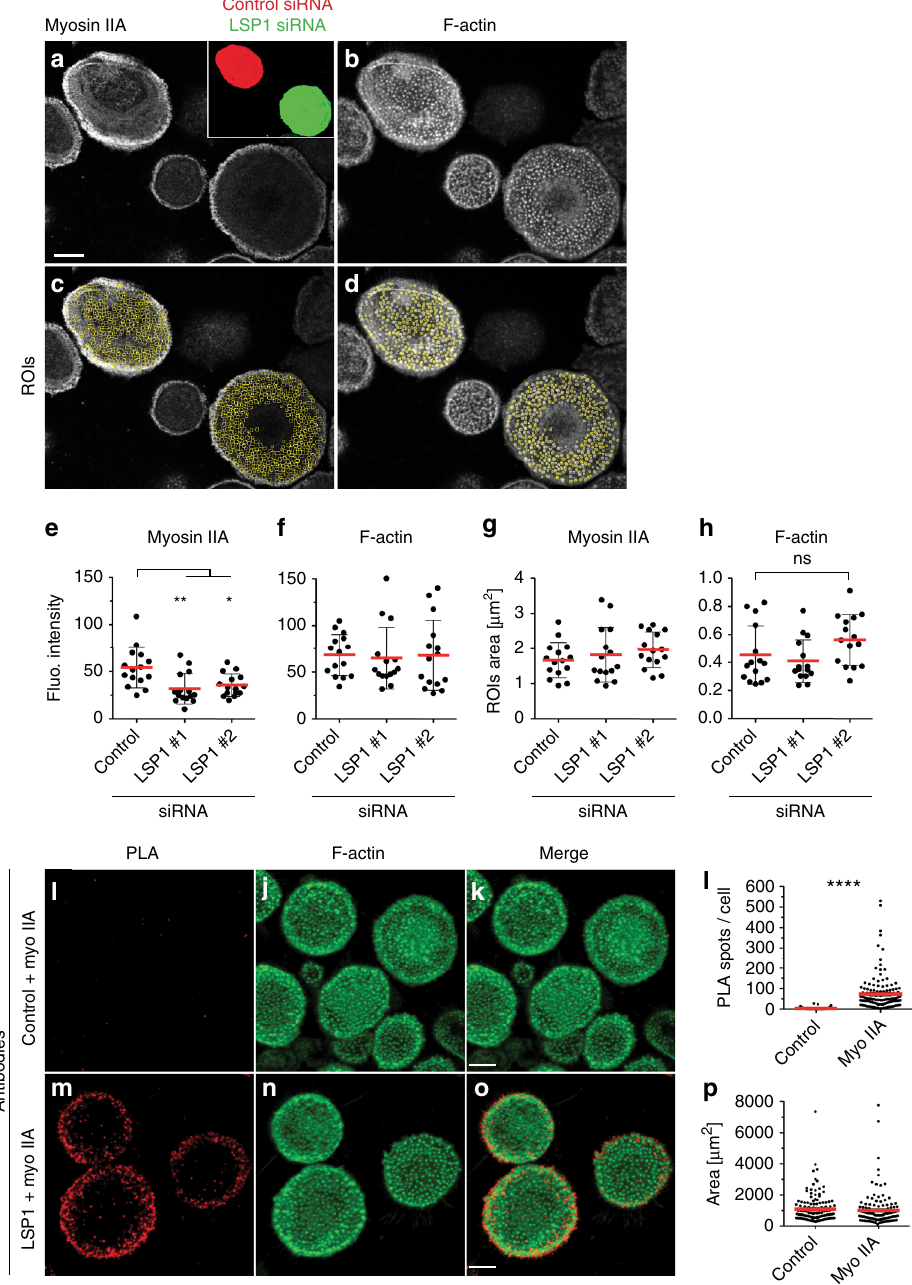
Fig. 4 LSP1 interacts with myosin IIA and regulates its recruitment to podosomes. a , b Confocal micrographs of mixed populations of macrophages, stained for myosin IIA using speci fi c primary antibody ( a ) or for F-actin using Alexa-405-labeled phalloidin ( b ). Cells treated with LSP1 siRNA express GFP, cells treated with control siRNA express mCherry, as shown in inset in a . c , d ImageJ-based macros were used to identify myosin IIA at podosomes ( c ) and F-actin-rich podosome cores ( d ). Scale bar: 10 µ m. e – h Statistical evaluation of ( e ) myosin-based fl uorescence at podosomes, ( f ) F-actin-based fl uorescence at podosomes and size of areas analysed for podosomal myosin IIA ( g ) and F-actin ( h ) podosome-covered area. Each dot represents the mean intensity of all the individual podosomes detected in a single cell (~500 podosomes/cell on average), fi ve cells from three different donors. Values are given as mean ± SD. * P < 0.05, ** P < 0.01, one-way ANOVA test. i – k , m – o Confocal micrographs of macrophages subjected to a proximity ligation assay (PLA), using myosin IIA-speci fi c antibody, together with control IgG ( i ) or LSP1-speci fi c antibody ( m ) and stained for F-actin ( j , n ), with merges ( k , o ). Scale bars: 10 µ m. Note low background in i and PLA signals, especially at the cell cortex, in m . l , p Statistical evaluation of number of PLA spots per cell ( l ) and cellular area analysed for respective PLAs ( p ). Each dot represents one cell. Data collected from two different donors. Values are given as mean ± s.e.m. **** P < 0.0001, two-tailed unpaired t -test. For speci fi c values,